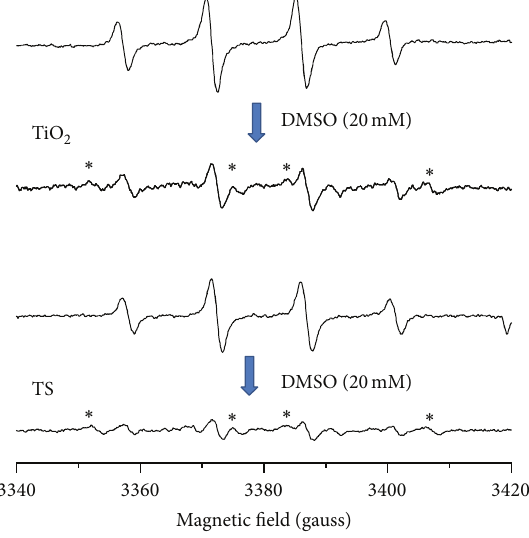
Figure 9: Effect of DMSO on the ∙ DMPO-OH signal during UV-Vis irradiation of aqueous suspensions of TiO 2 and